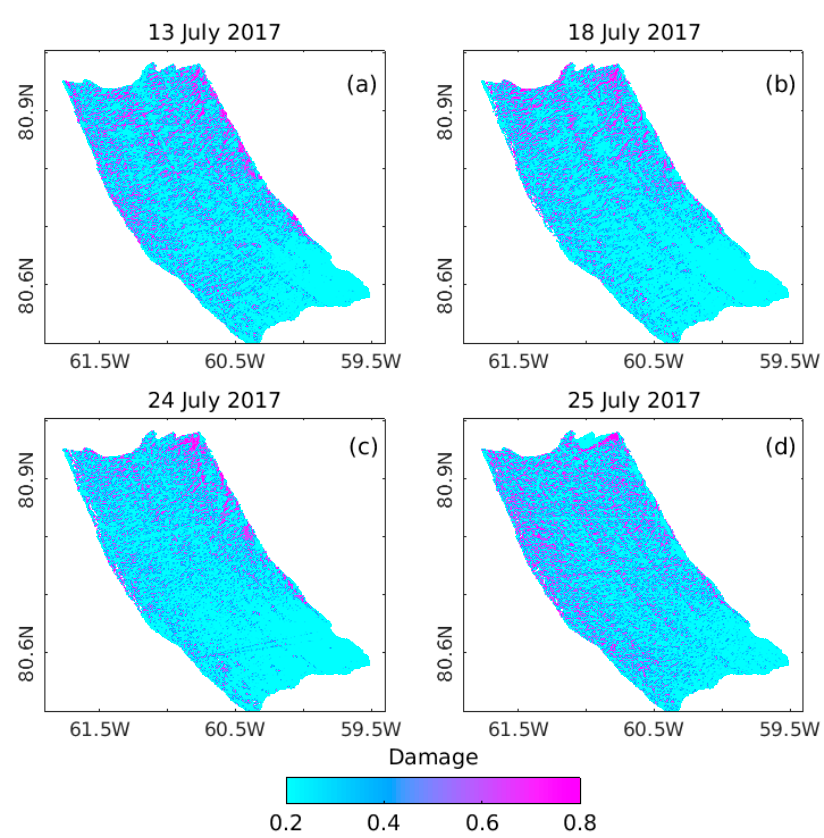
Figure 7. The damage scalar series of the Petermann Glacier on the days in July 2017, prior to the calving. ( a – d ) respectively represent mean damage scalar from the corresponding periods.